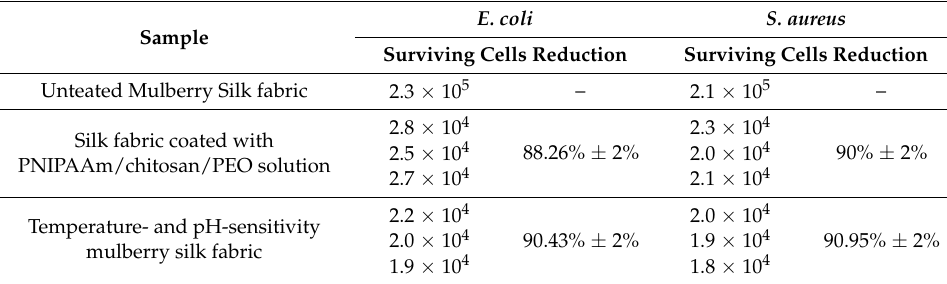
Table 1. Antibacterial activities of the silk